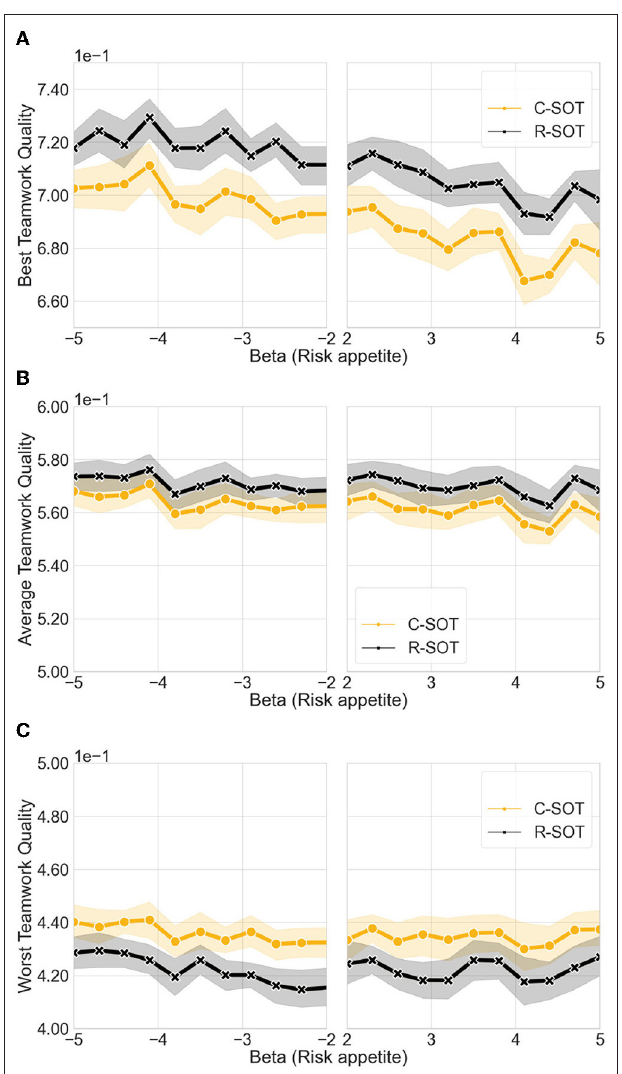
FIGURE 3 | Comparison of the best and worst teamwork quality between bottom-up models, namely C-SOT and R-SOT, with varying risk appetite levels . The x axis illustrates the different risk levels generated according to two mirroring beta distributions: negative values ( β ∈ [ − 5, − 2]) illustrate an exploratory, risk-prone user behavior (the more negative the more risk-prone); positive values ( β ∈ [2,5]) illustrate an exploitative, risk-averse behavior (the more positive the more risk-averse). We observe that the best teamwork quality is affected by risk appetite, and that it decreases for both models as the users’ willingness to change teams decreases. The average and worst teamwork quality remain unaffected by changes in the user population’s risk levels. (A) Best teamwork quality for C-SOT and R-SOT with different risk appetite levels. (B) Average teamwork quality for C-SOT and R-SOT with different risk appetite levels. (C) Worst teamwork quality for C-SOT and R-SOT with different risk appetite levels.